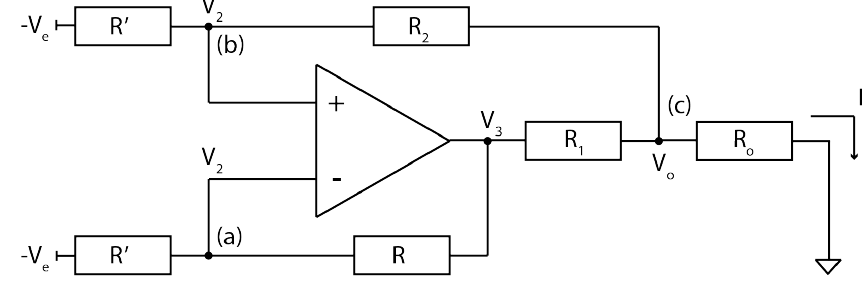
Figure A2. Error model for a transconductance